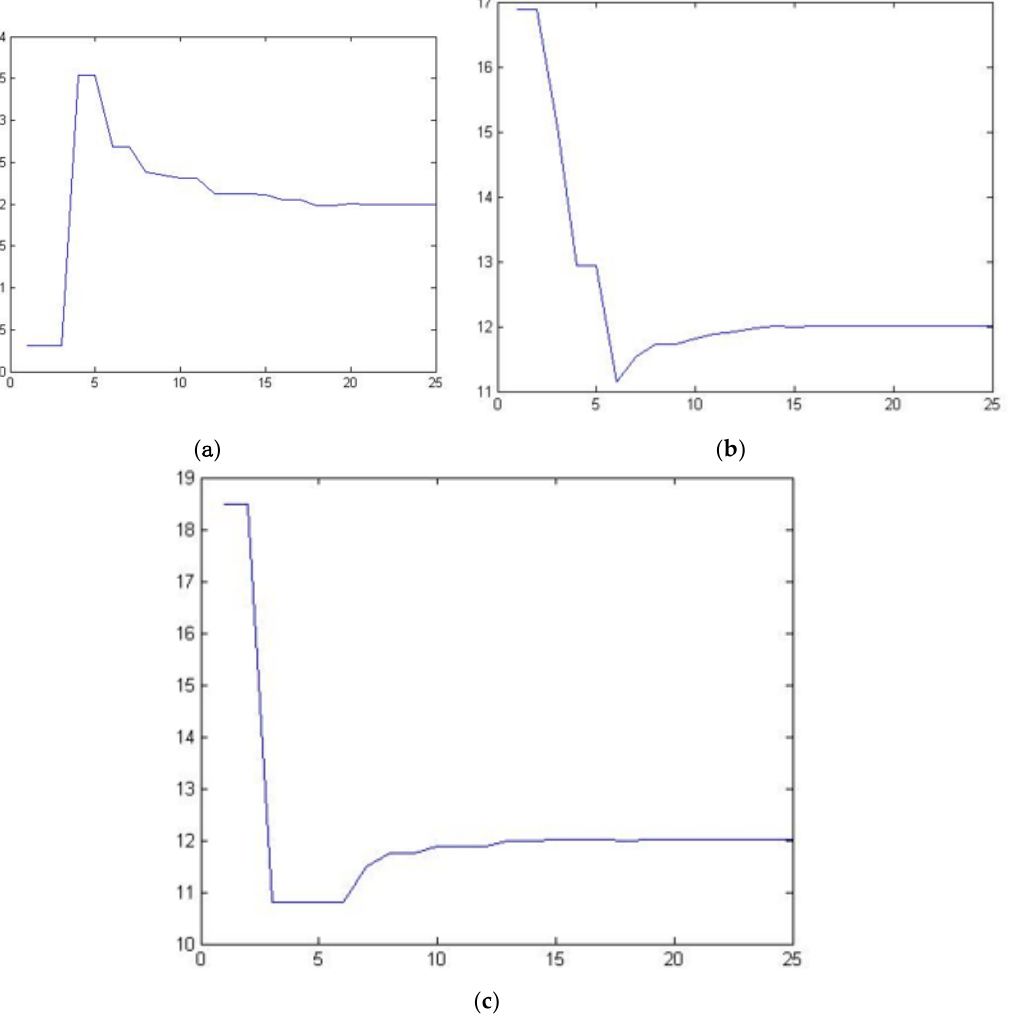
Figure 3. Artificial bee colony algorithm (ABCA) inversion convergence curve. (a) First inversion; (b) Second inversion; (c) Third inversion.